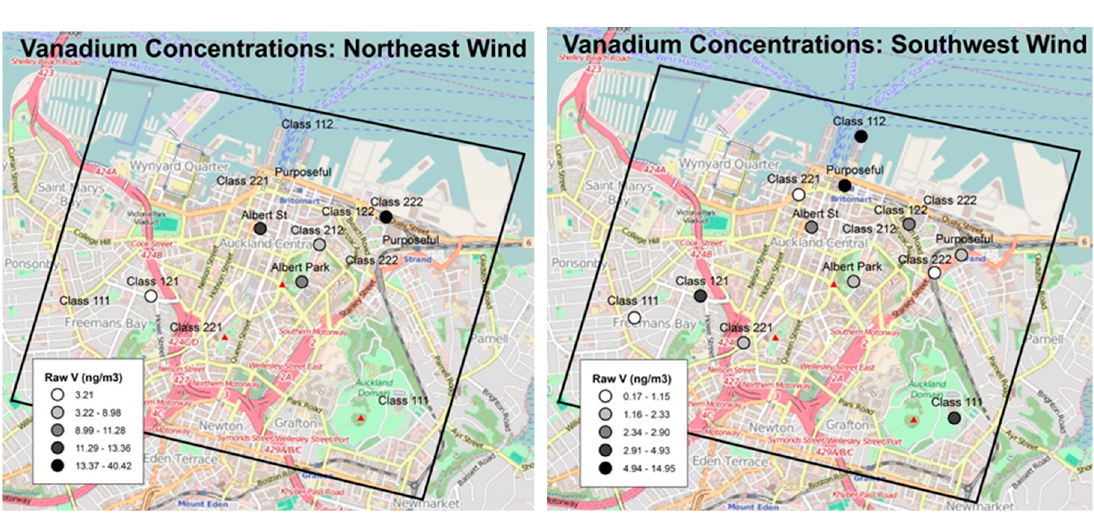
Figure 5. Maps of elevated vanadium concentrations were detected during Session 2 (predominant winds from north-east), versus lower concentrations during Sessions 1, 3, and 4 (winds from southwest). Note that maps are on different scales for visualization purposes.